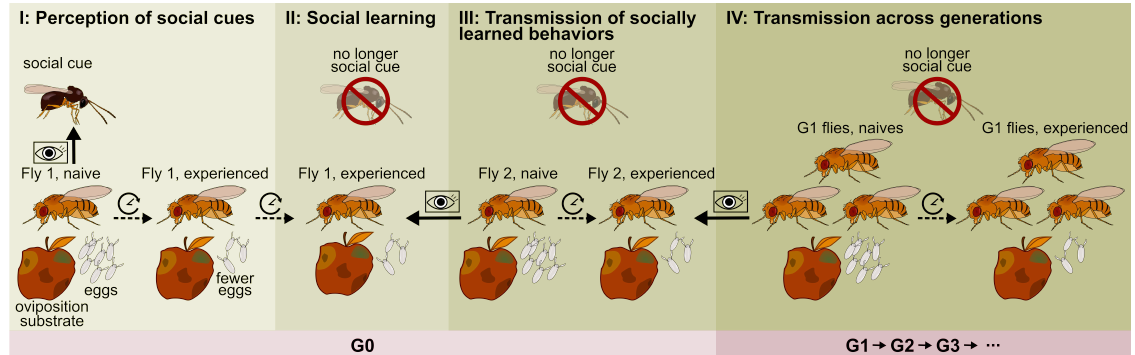
Figure 1. The steps involved in social inheritance. Step I Perception of social cues: Fly 1 perceives a social cue, e.g., the presence of a parasitic wasp that can parasitize and kill the larvae of Drosophila melanogaster (based on [21]). In response to the social cue, fly 1 changes its behavior, e.g., the female D. melanogaster reduces oviposition (fewer eggs are laid). The behavioral change proves that the cue is perceived. Step II Social learning: Fly 1 has learned about the social cue and is now experienced, meaning that the behavioral adjustment persists in time even when the social cue is no longer present, e.g., D. melanogaster females continue laying fewer eggs even when the wasp has left the patch. Step III Transmission: The socially learned behavior is taken over by naive fly 2 from experienced fly 1 (i.e., through visual and olfactory cues) that then changes its behavior. Step IV Transmission across generations: The socially learned behavior spreads throughout the population and over subsequent generations, e.g., other Drosophila females (including those belonging to other species) perceive the behavioral change of individuals 1 or 2 and also reduce their egg numbers (based on [22]). For social inheritance, naive flies belonging to the next generation should acquire behaviors from experienced flies exhibiting socially learned behaviors. This remains to be tested explicitly in the example of social learning of wasp threats in Drosophila. Of note, social inheritance can produce culture, based on additional criteria for transmission of socially learned behaviors as described in